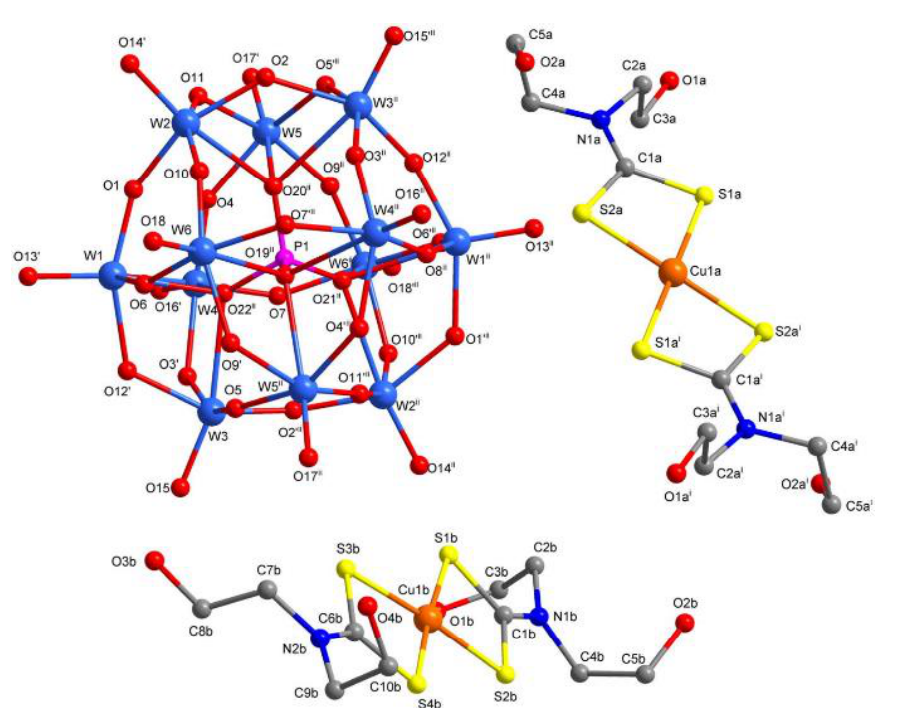
Figure 30. Organic – inorganic nanohybrid [Cu{S 2 CN(CH 2 CH 2 OH) 2 } 2 ] 3 [PW 12 O 40 ]. Reproduced with permission from [85]. Copyright 2017